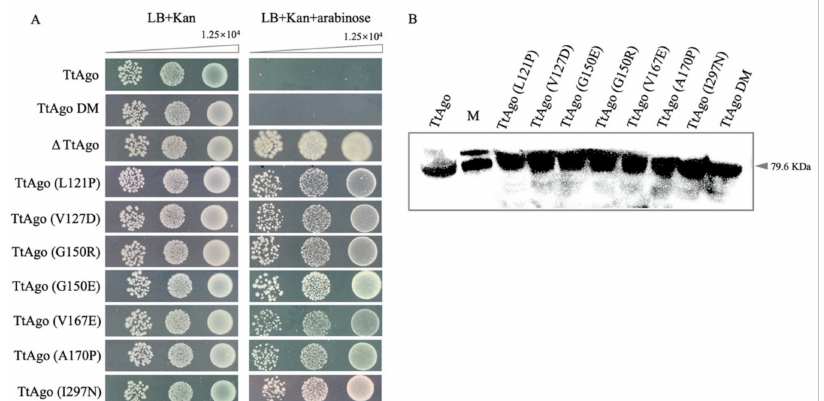
Figure 10. Function analysis of TtAgo mutants in E. coli DH5 α . ( A ) Colony spot plating assay for pET28a-pBAD-TtAgo, pET28a-pBAD-TtAgoDM, pET28a-pBAD- ∆ TtAgo, and randomly picked TtAgo mutants, with and without L-arabinose induction. The pET28a-pBAD-TtAgo represents intact TtAgo enzyme activity, and pET28a-pBAD- ∆ TtAgo represents enzymatic dead TtAgo activity. Three biological replicates were performed for each group. ( B ) Protein expression examination by Western blotting. Cell cultures from (A) were inoculated into 4 mL LB+Kan medium and were induced with L-arabinose (10 mM) for 4 h when OD 600 reached approximately 0.5. Total protein was extracted for Western blotting with His-Tag Mouse Monoclonal antibody.